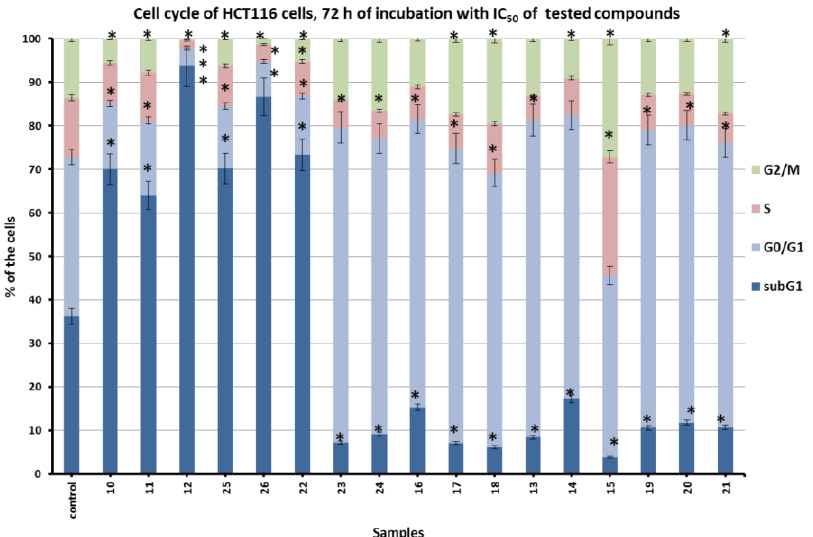
Figure 3. Cell cycle distribution in HCT116 cells after 72 h of incubation with tested compounds at IC 50 dose or 100 µ M for no effective compounds based on Table 2. The subG1 fraction represents apoptotic and dead cells. Results presented as means from 3 experiments, ± SD. Statistical significance indicated by star; evaluated by T-test, where p < 0.05.